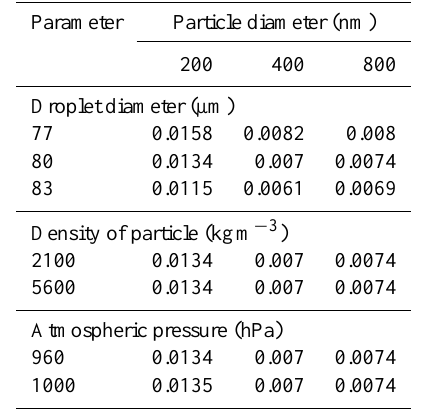
Table 1. Dependency of collision efficiency on droplet diameter, particle density and atmopheric